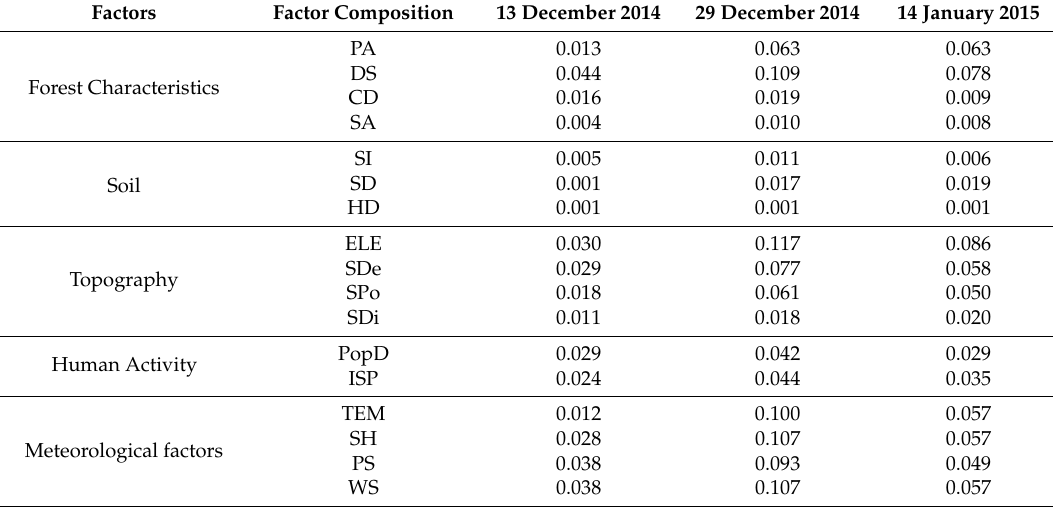
Table 2. The power of determinant (PD) of forest attributes, soil, topography, meteorological factors, and population on PM 2.5 concentrations on three different